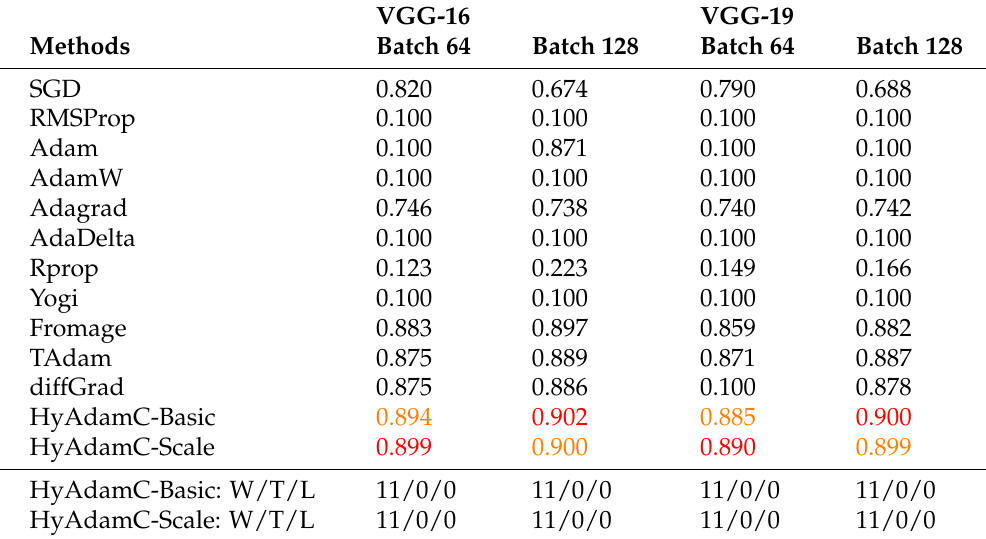
Table 6. The test accuracies of the VGG-16 and 19 trained by the optimization methods for the CIFAR- 10 image dataset classification task. “W (Win)”, “T (Tie)”, and “L (Loss)” refer to the number of the compared methods for which HyAdamC-Basic (or HyAdamC-Scale) achieved better, equivalent, and worse test accuracies, respectively. The first and second best results are highlighted in red and orange,